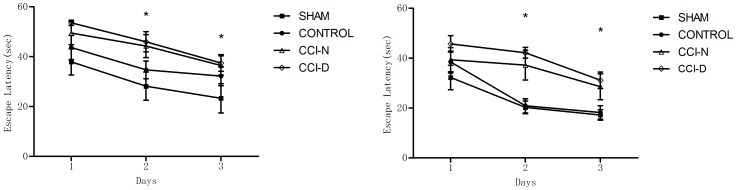
The changes of latency time.(a). 8 weeks after CCI (left). (b). 2 weeks after rhGH treatment (right). Note: *difference of P<0.05 between the four groups at the same time point.